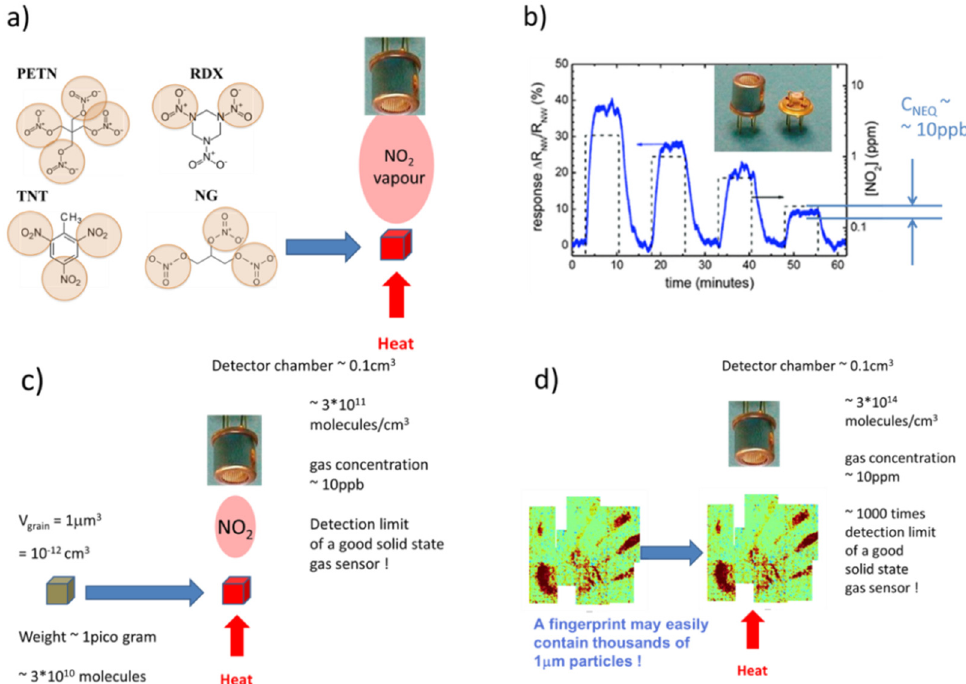
Figure 10. Use of MOX gas sensors for explosives detection: ( a ) explosives disintegration producing NO 2 vapors; ( b ) NO 2 sensitivity of a commercial NO 2 sensor featuring a noise ‐ equivalent resistive response of about 10 ppb; ( c ) an evaporation/disintegration of a 1 ‐μ m grain of explosive producing the noise ‐ equivalent NO 2 concentration; ( d ) thermal conversion of a hand/finger print of explosives